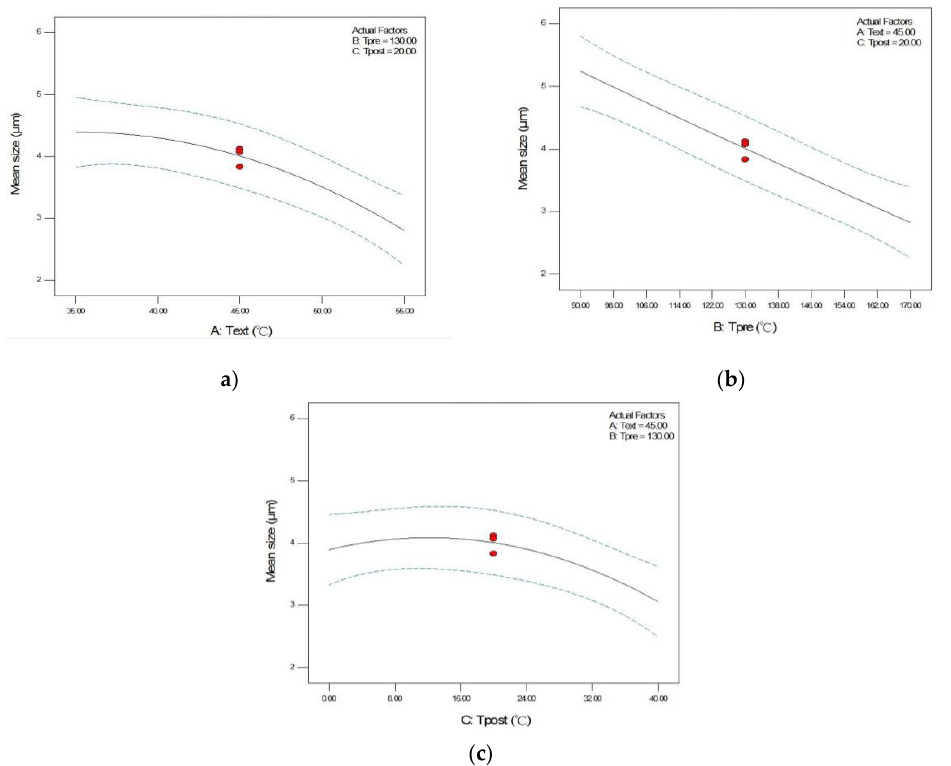
Figure 2. Effects of ( a ) extraction temperature ( b ) pre-expansion temperature, and ( c ) post-expansion temperature on the mean size of RESS-processed ethenzamide crystals using Box–Behnken design.